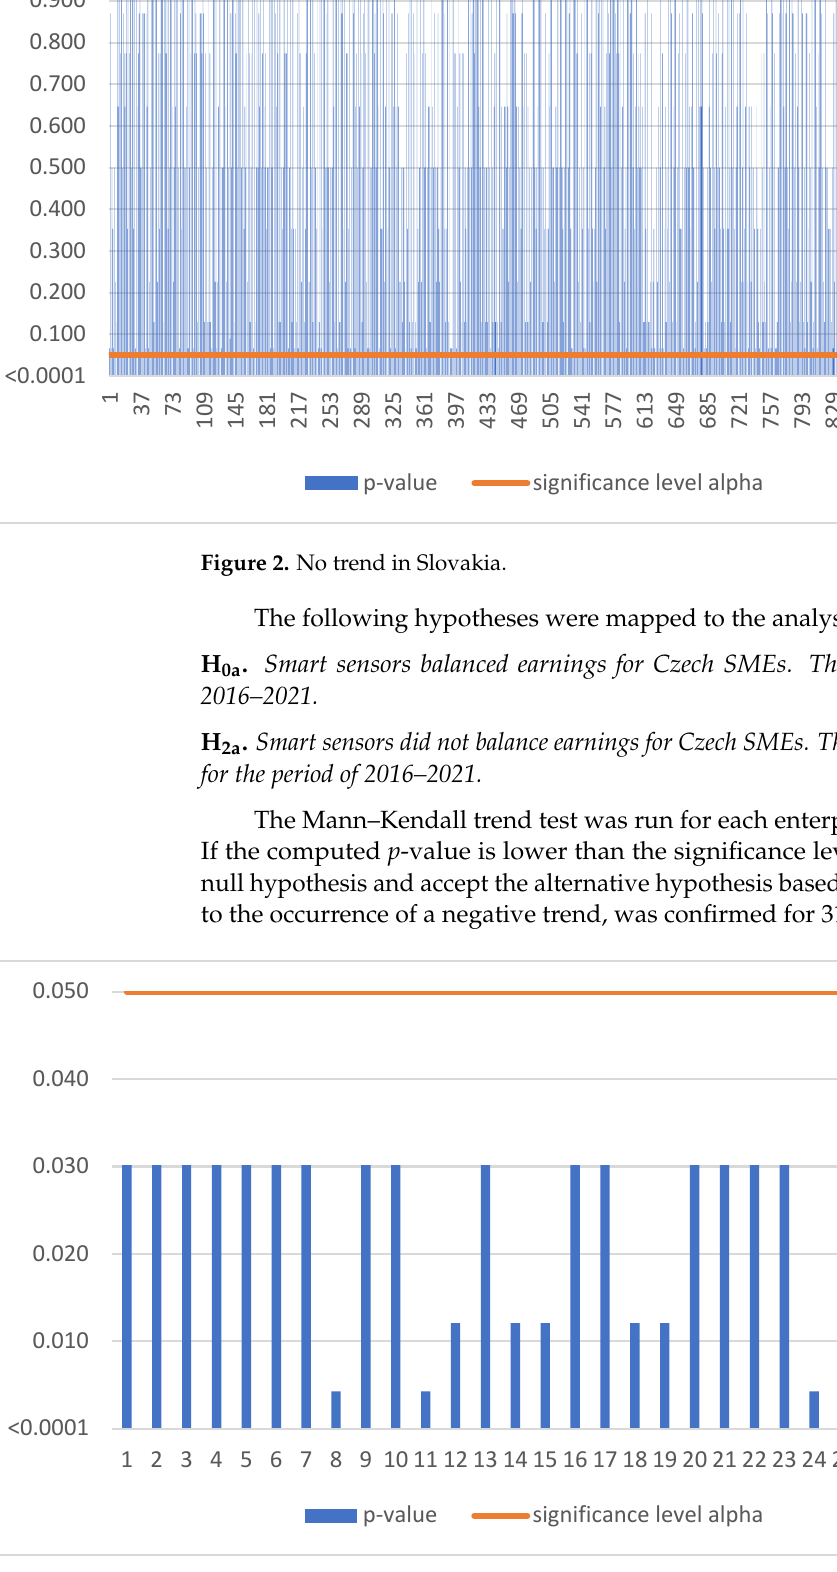
Figure 3. Negative trend in Czechia.